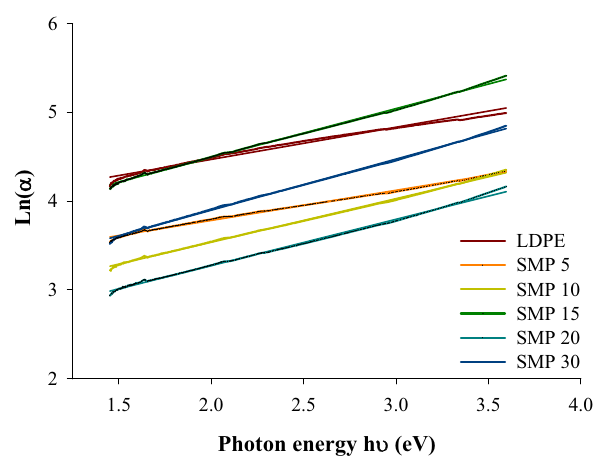
Figure 6: Initial TGA thermograms for LDPE and LDPE - g - MMA/Py.